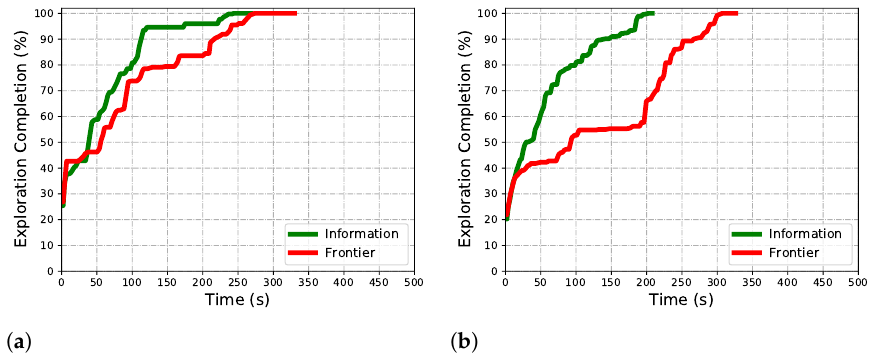
Figure 12. Algorithm comparison in maze scenario. ( a ) Exploring completion degree curve. ( b ) Total completion